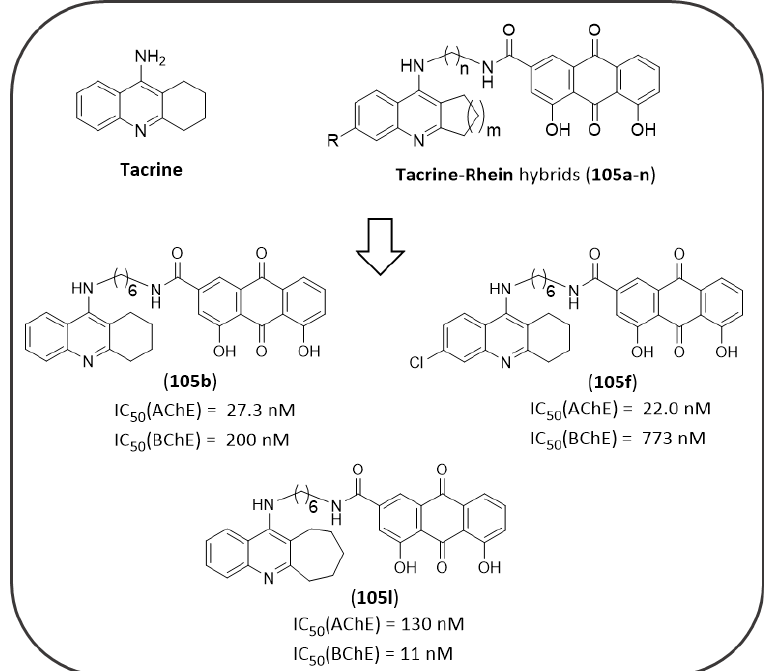
Figure 22. Representative tacrine-rhein hybrids.